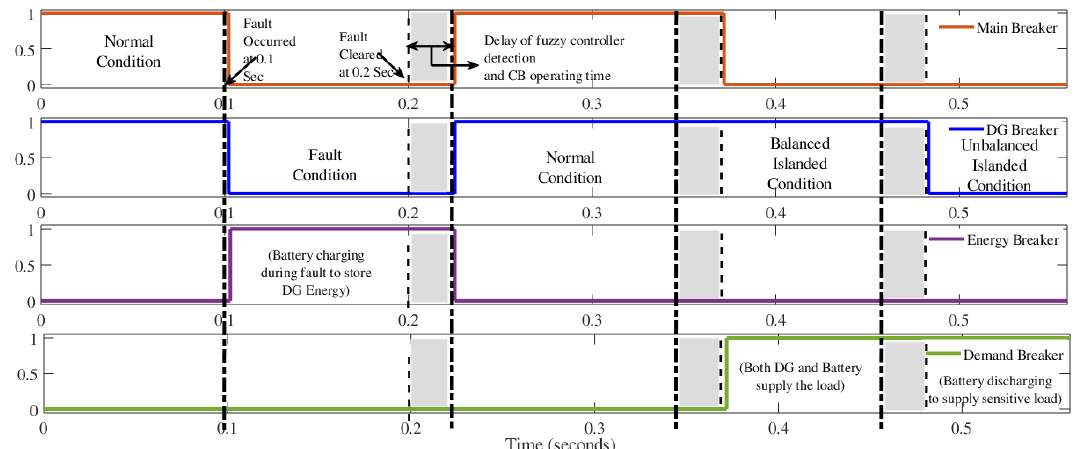
Figure 11. Switching patterns generated using the fuzzy inference system for circuit breakers under different operating